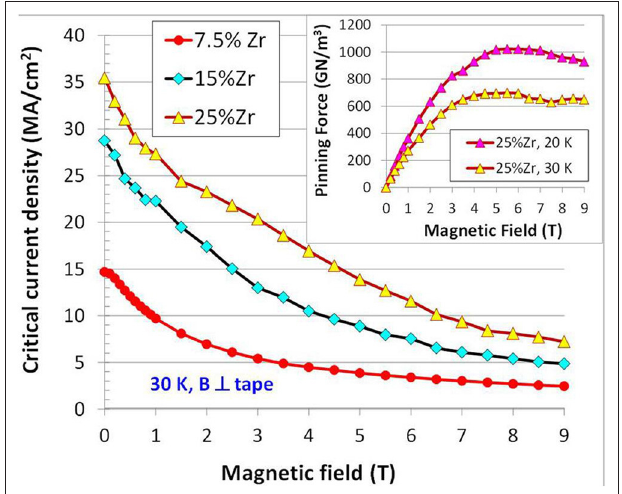
FIGURE 13 | Variation of critical current density with applied magnetic field for 7.5, 15, and 25mol.% Zr-added (Gd,Y)BCO superconductor tapes at 30K for H perpendicular to the tape. Variation of pinning force density of 25mol.% Zr-added (Gd,Y)BCO superconductor tape at 30 and 20K is shown in the inset. Reprinted from Selvamanickam et al. [113], with the permission of AIP Publishing.